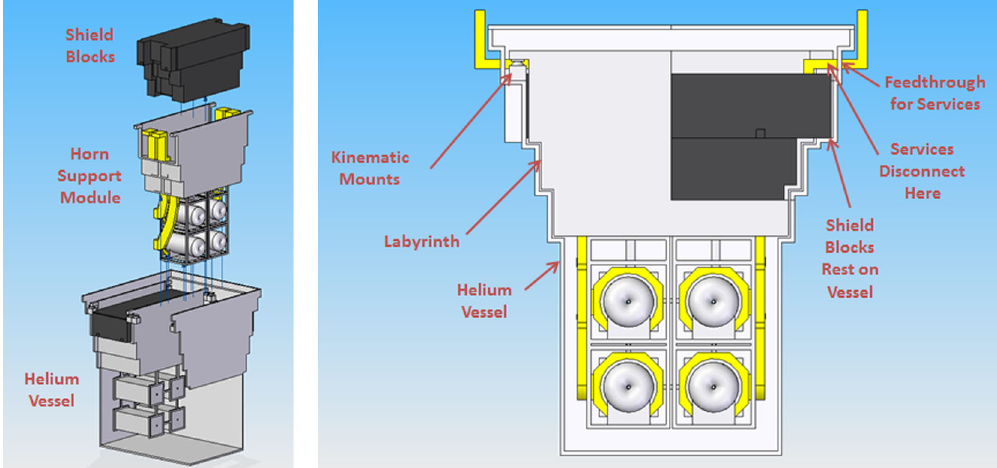
FIG. 10. Support modules, shield blocks, and helium